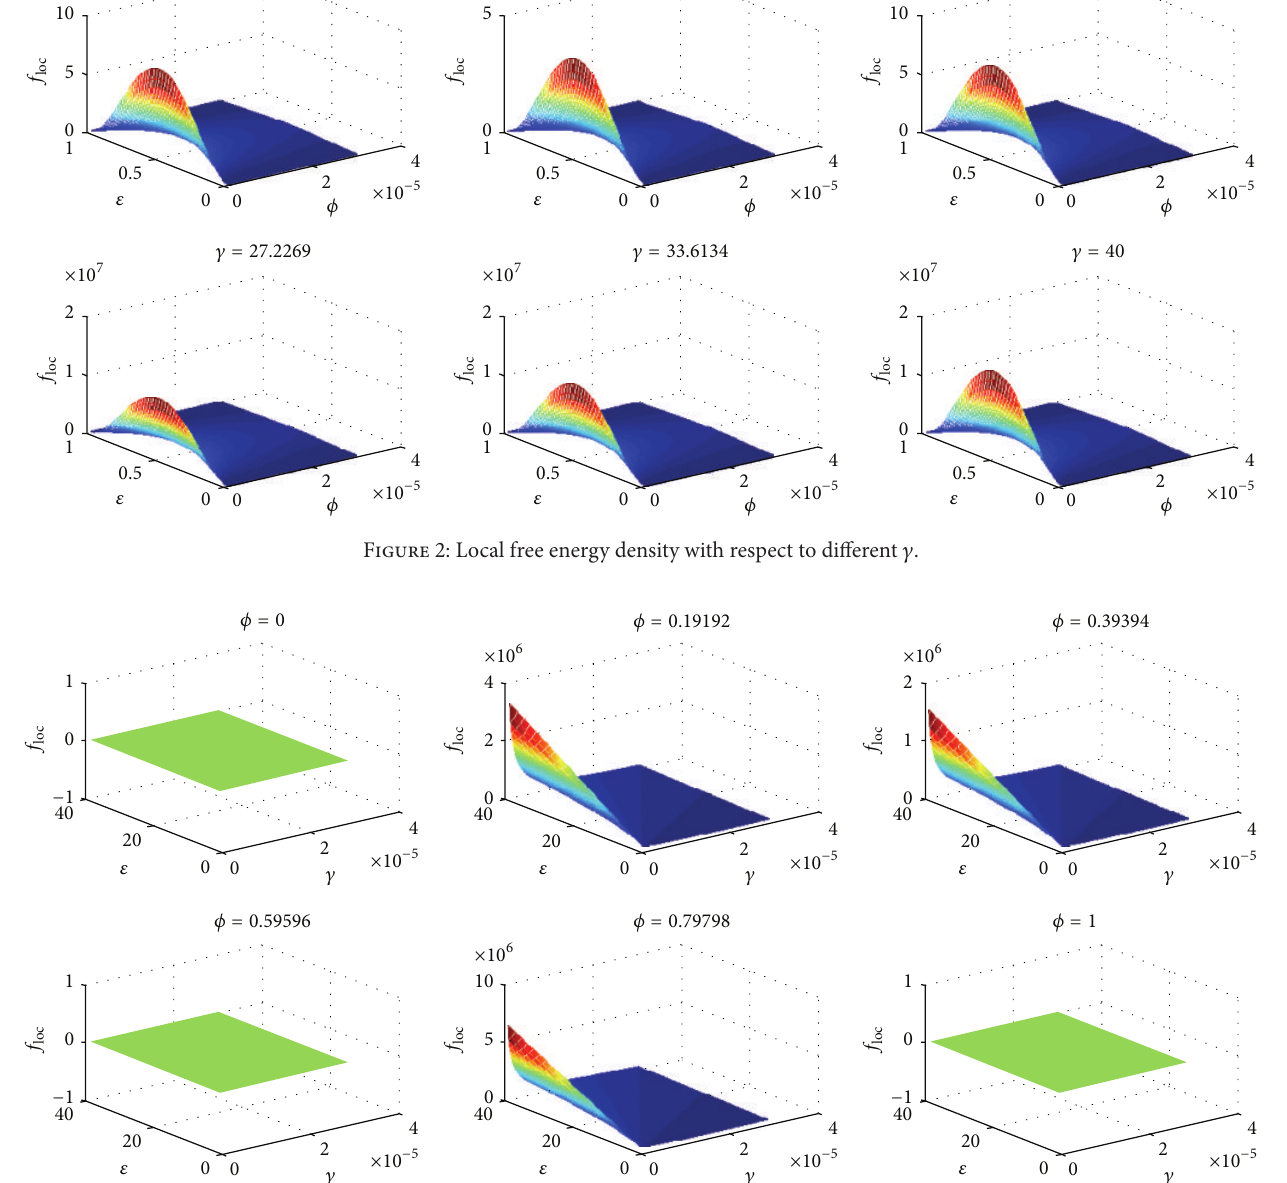
Figure 3: Local free energy density with respect to different 𝜙